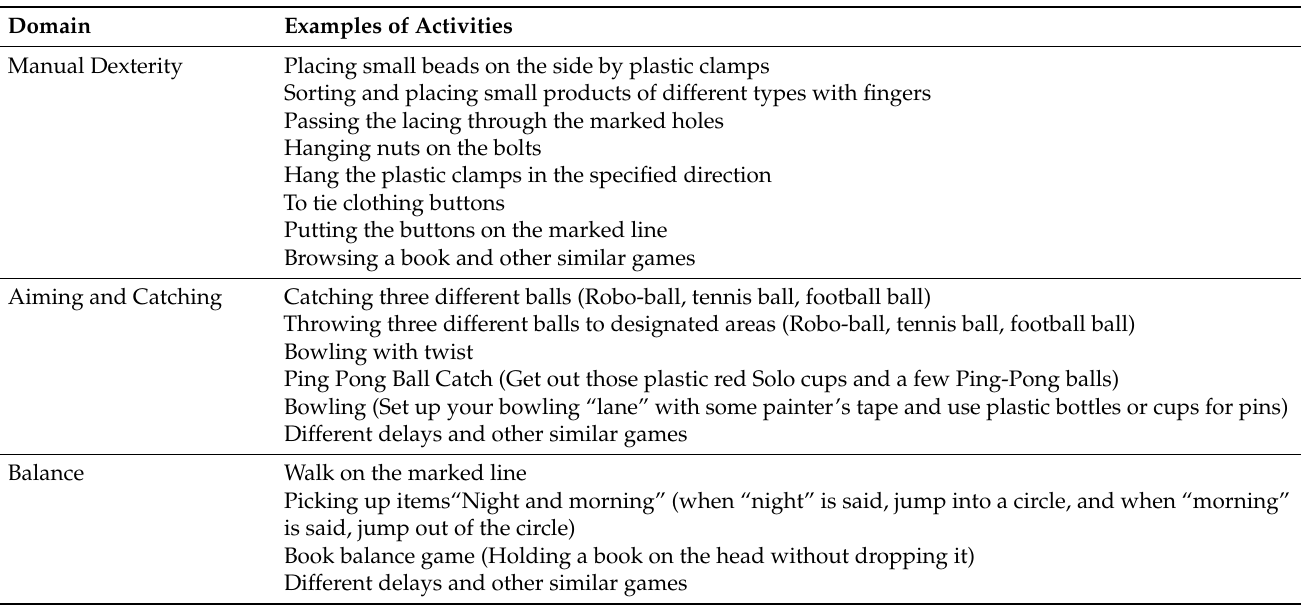
Table 2. Motor skills training program. Examples of